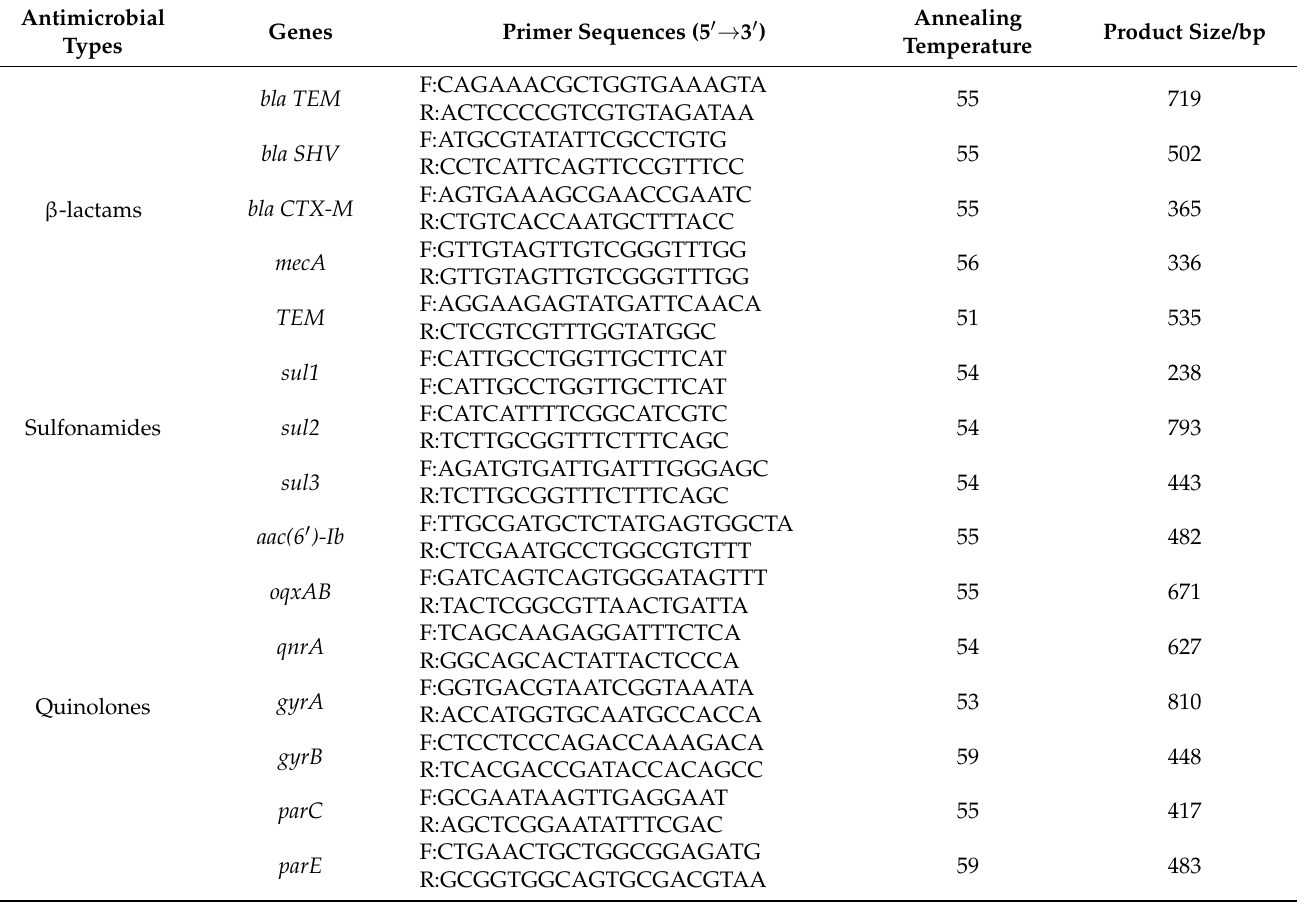
Table 1. Primer sequence information of drug resistance